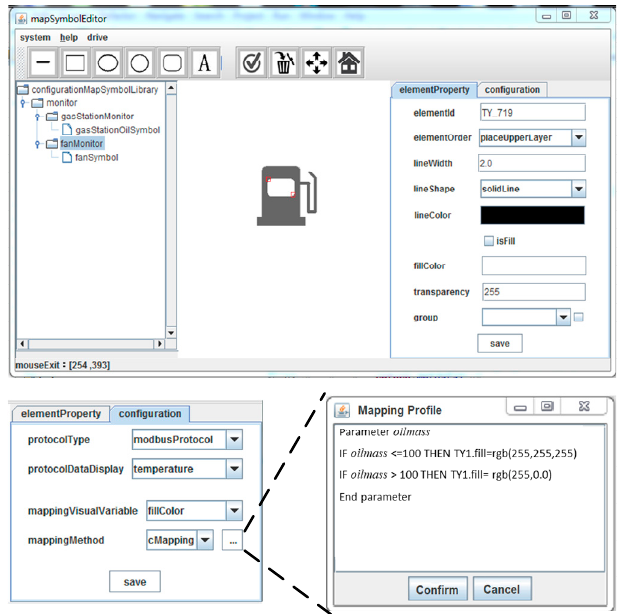
Figure 5. The user interface (UI) of the protocol-coupling map symbol construction software integrated with the geo-sensor protocol parsing interface.